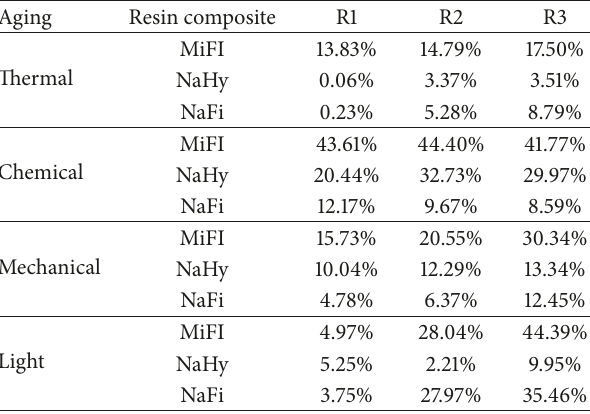
Table 2: Percentage of surface gloss reduction after each reading (R1 to R3) in relation to